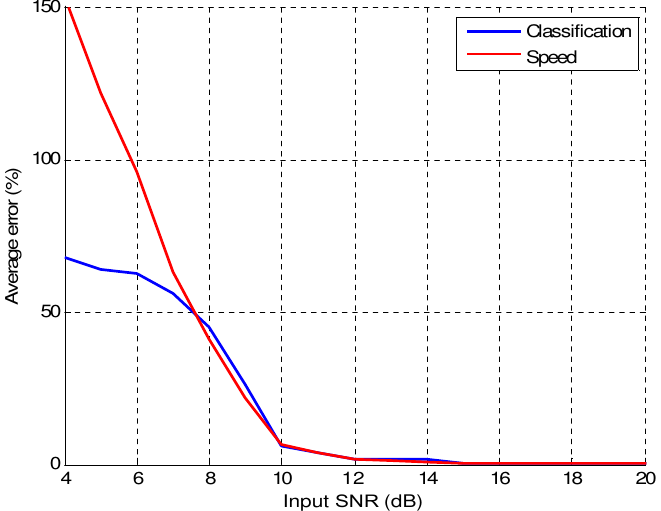
Figure 20. Influence of Additive White Gaussian Noise (AWGN) on vehicle classification and speed estimation